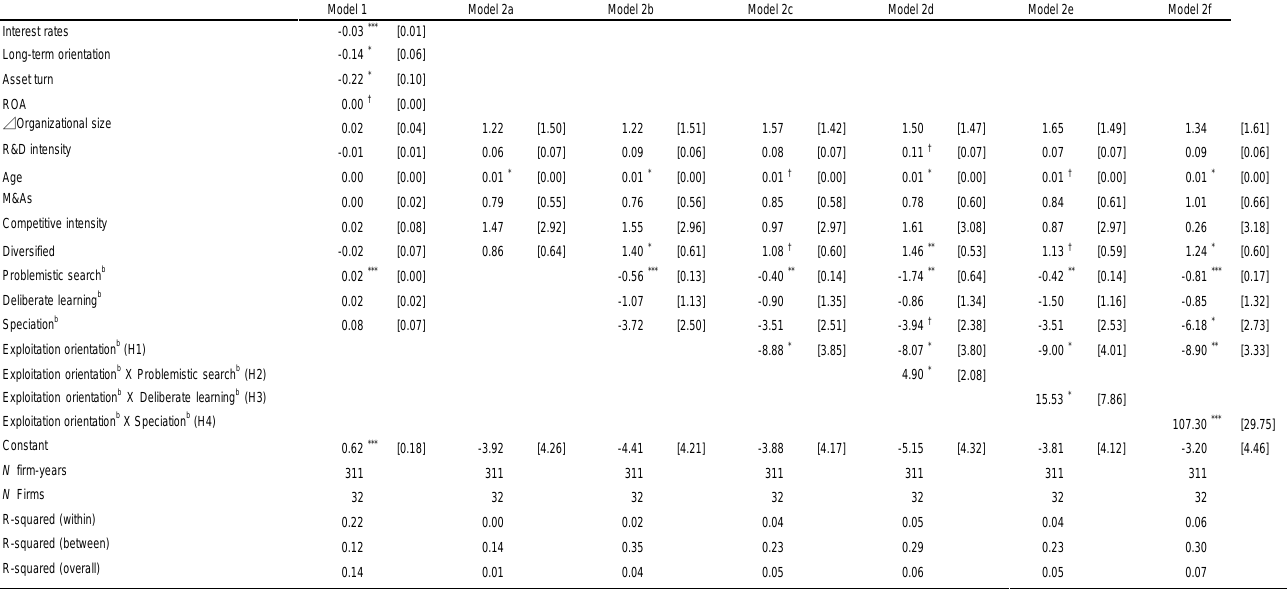
Note: Dependent variable for Model 1 is exploitation orientation, while that for Model 2a to Model 2f is a. Robust standard errors adjusted for clustering by firm are in parentheses. Two-tailed tests for all effects. b. Mean